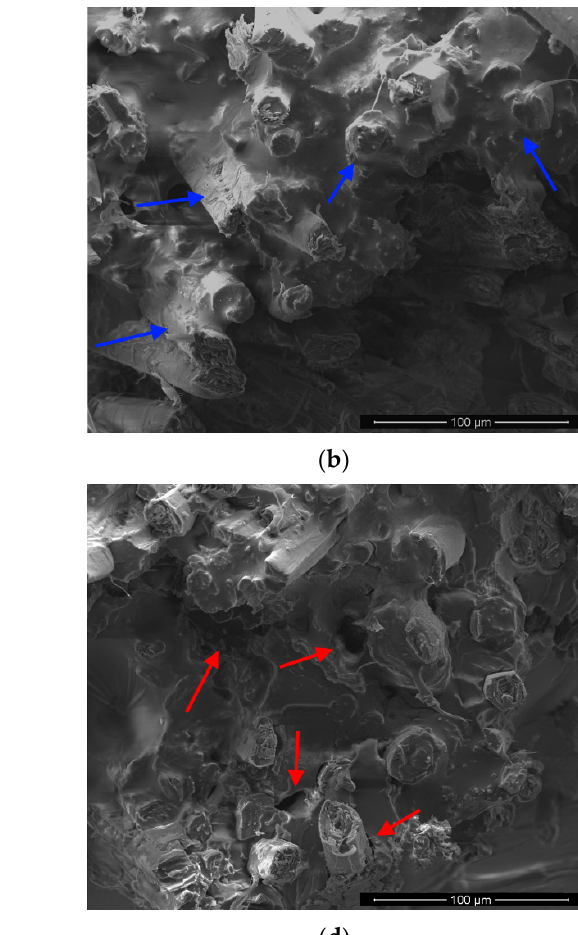
( d ) Figure 9. SEM micrographs at low magnification (250×) of tensile fractured surfaces: ( a ) R, ( b ) C5, ( c ) C10 and ( d ) C20 composites.